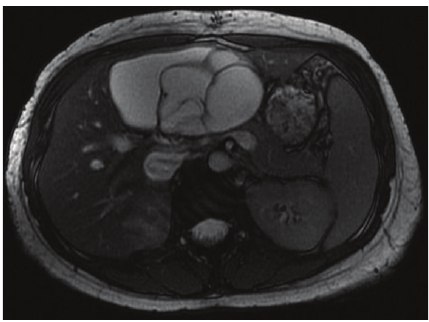
Figure 2: Name: axial 2D FIESTA. Description: multiple low T2 signal septations were seen within the mass on MRI.